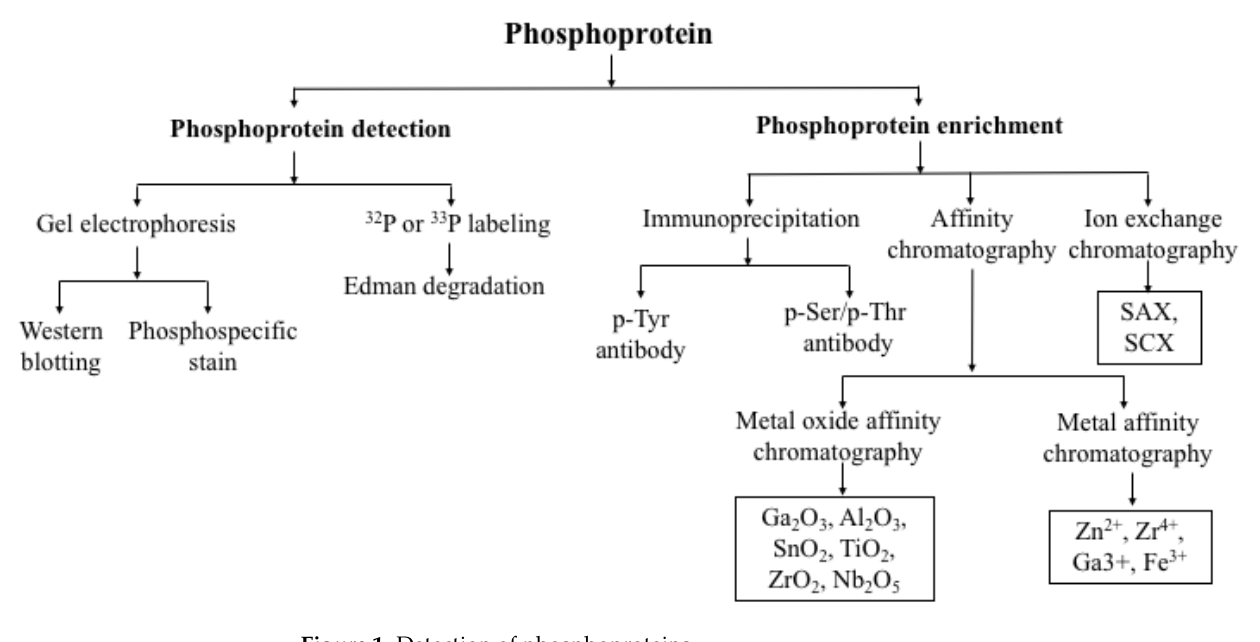
Figure 1. Detection of phosphoproteins.